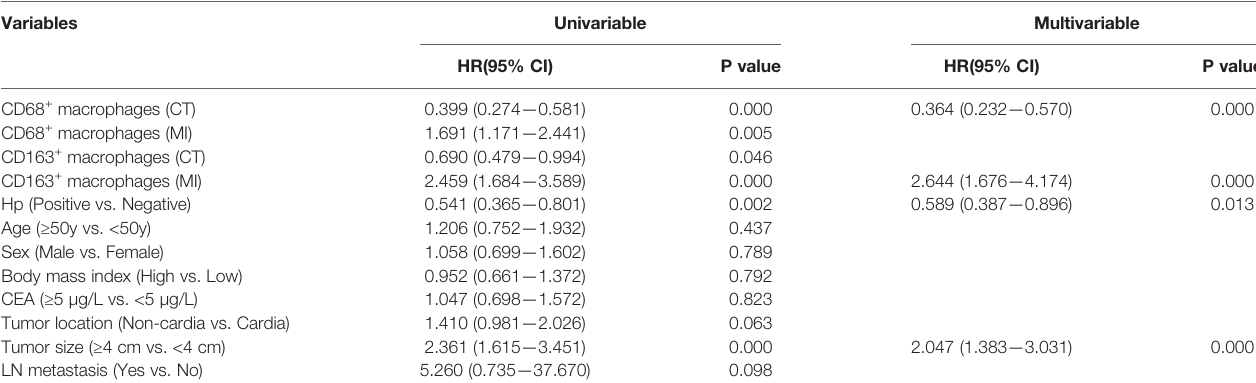
TABLE 2 | Cox proportional hazards models between clinical and survival in patients with gastric